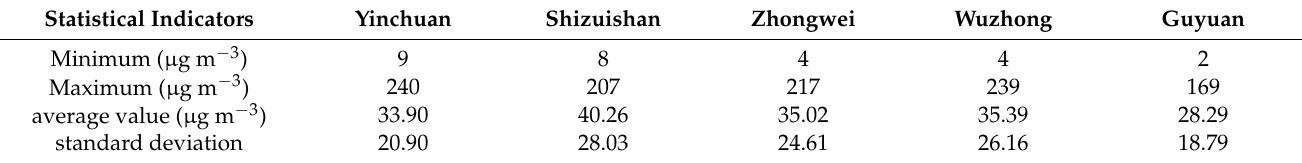
Figure 2. Five cities’ AQI grade percentage stacked chart. Table 2. The main statistical indicators of PM2.5 in air quality monitoring stations.